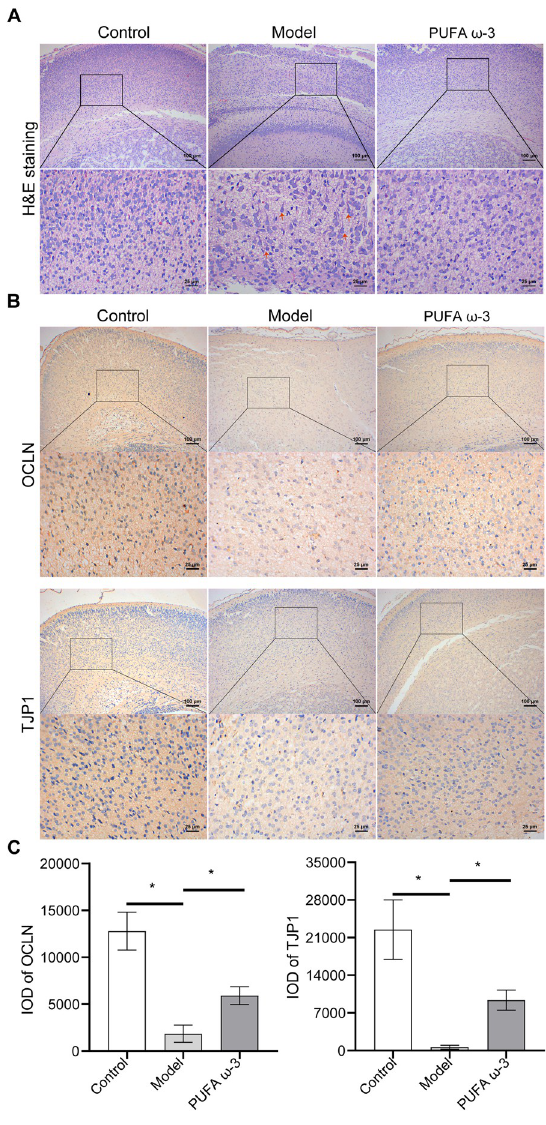
Fig 3. PUFA ω -3 alleviates fetal brain damage induced by sodium nitrite exposure during pregnancy. (A) Representative images of brain tissues from each group were analyzed by H&E staining, n = 3 rats/group. (B) Representative images of OCLN and TJP1 expression in brain tissues of each group, as measured by immunohistochemistry, n = 3 rats/group. Blue indicates nuclei. Light red indicates cytoplasm. Red arrows indicate typical nuclear damage. (C) Integrated optical density (IOD) values of representative images of OCLN and TJP1 expression in brain tissues of each group were analyzed by Image-Pro-Plus, n = 3 rats/group. � P < 0.05. H&E,